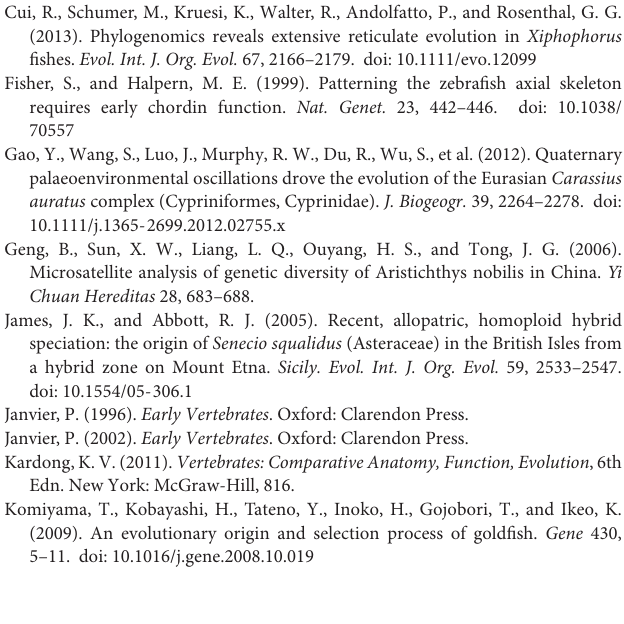
Supplementary Figure 1 | Nucleotide alignment of the sequenced exons (1 st to 6 th ) of the chordin gene from the four fish lines (RCC, CC, NG, EG). Asterisks ( ∗ ) indicate bases that differ among lines. The site of termination codon mutation is highlighted in blue. Supplementary Table 1 | Primer pairs and corresponding annealing temperatures for the six SSR loci used in this